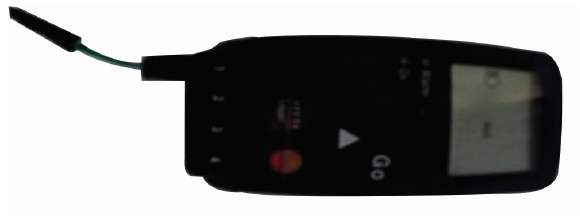
Figure 6. K-Type thermocouple